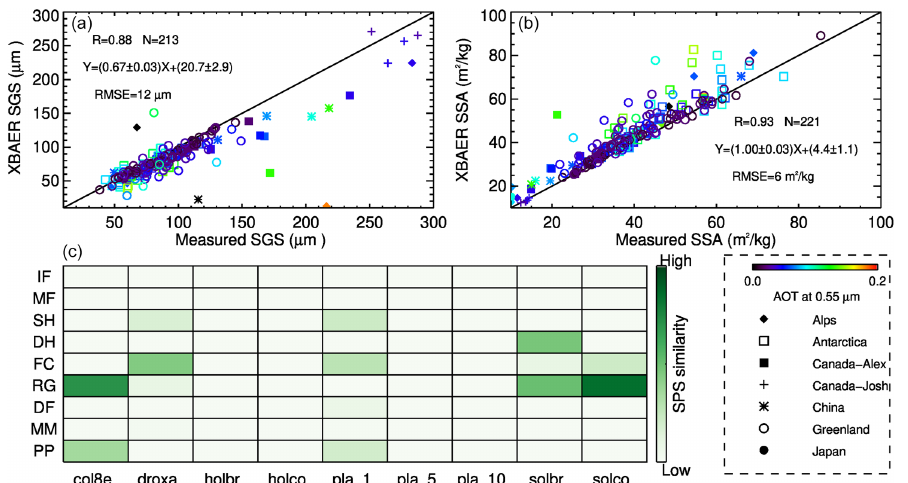
Figure 8. Validation of XBAER-derived SGS, SPS and SSA. The upper panels show the scatterplots for SGS and SSA, while the lower panel shows the relationship of SPS between XBAER and ICSSG . The match-ups for SGS and SSA are distinguished by sites and the AOT. The correlation coefficient ( R ), number of match-ups ( N ), regression equation and RMSE are given. The relationship of SGS between XBAER and ICSSG (named SPS similarity) is defined as the ratio of the number of given match-ups to the total match-ups.